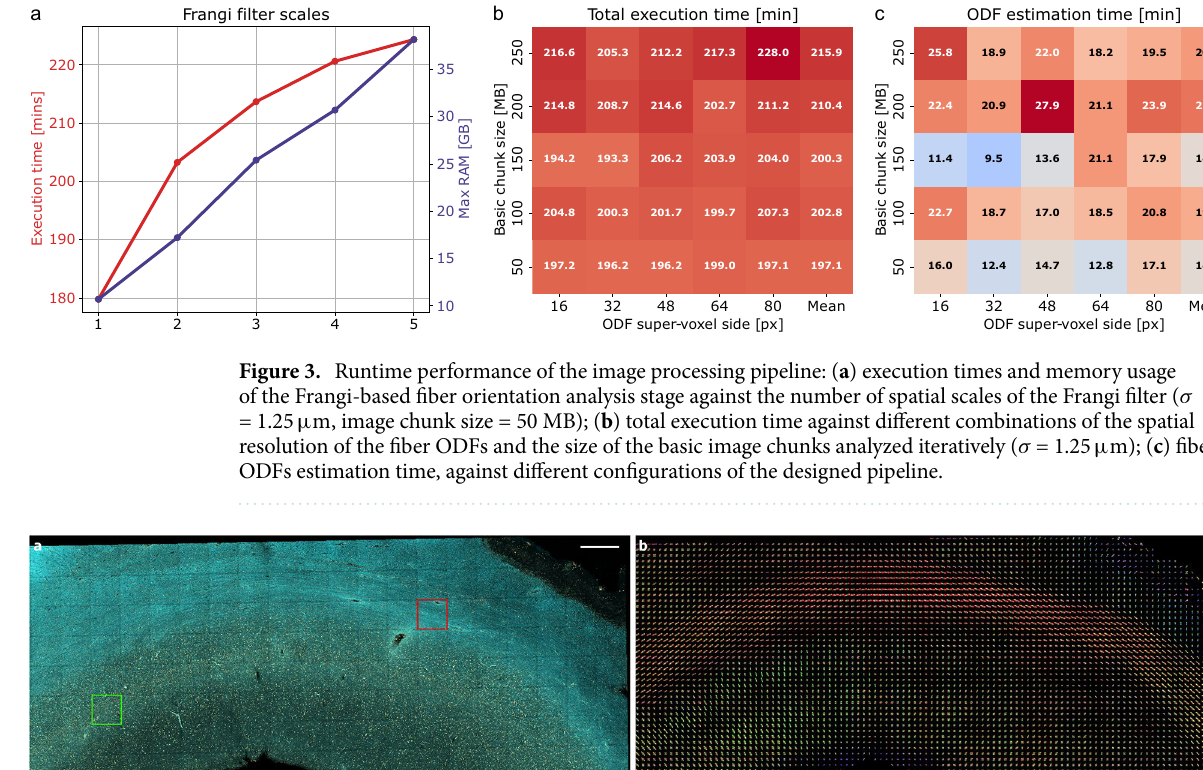
approach, which computes the spherical harmonics coefficients (Eq. 16) for each native voxel of the ODF com- partments, independently from their size. Similarly, processing larger chunks of the TPFM reconstruction does